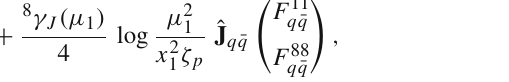
( z , x , y ,μ,μ) with P ( z ,μ) = a 11 F q ¯ q 2 1